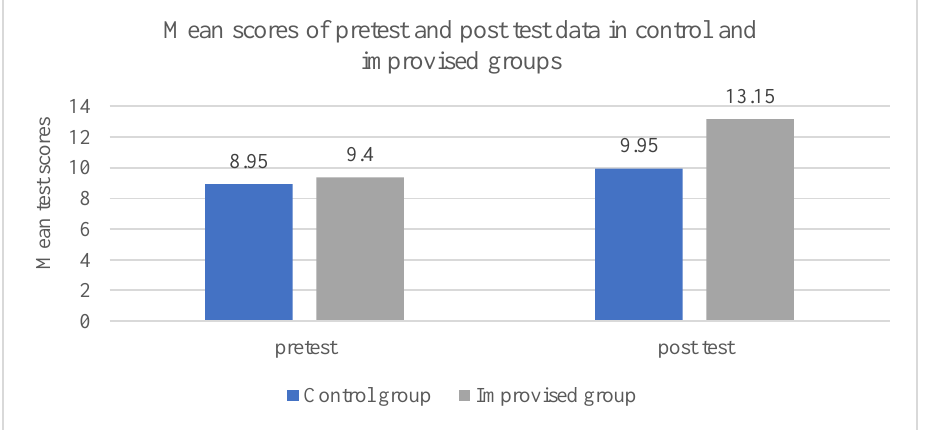
Figure 1 : Mean Scores Achieved in Pre-Test and Post-Test for Both Control and Improvised Resources